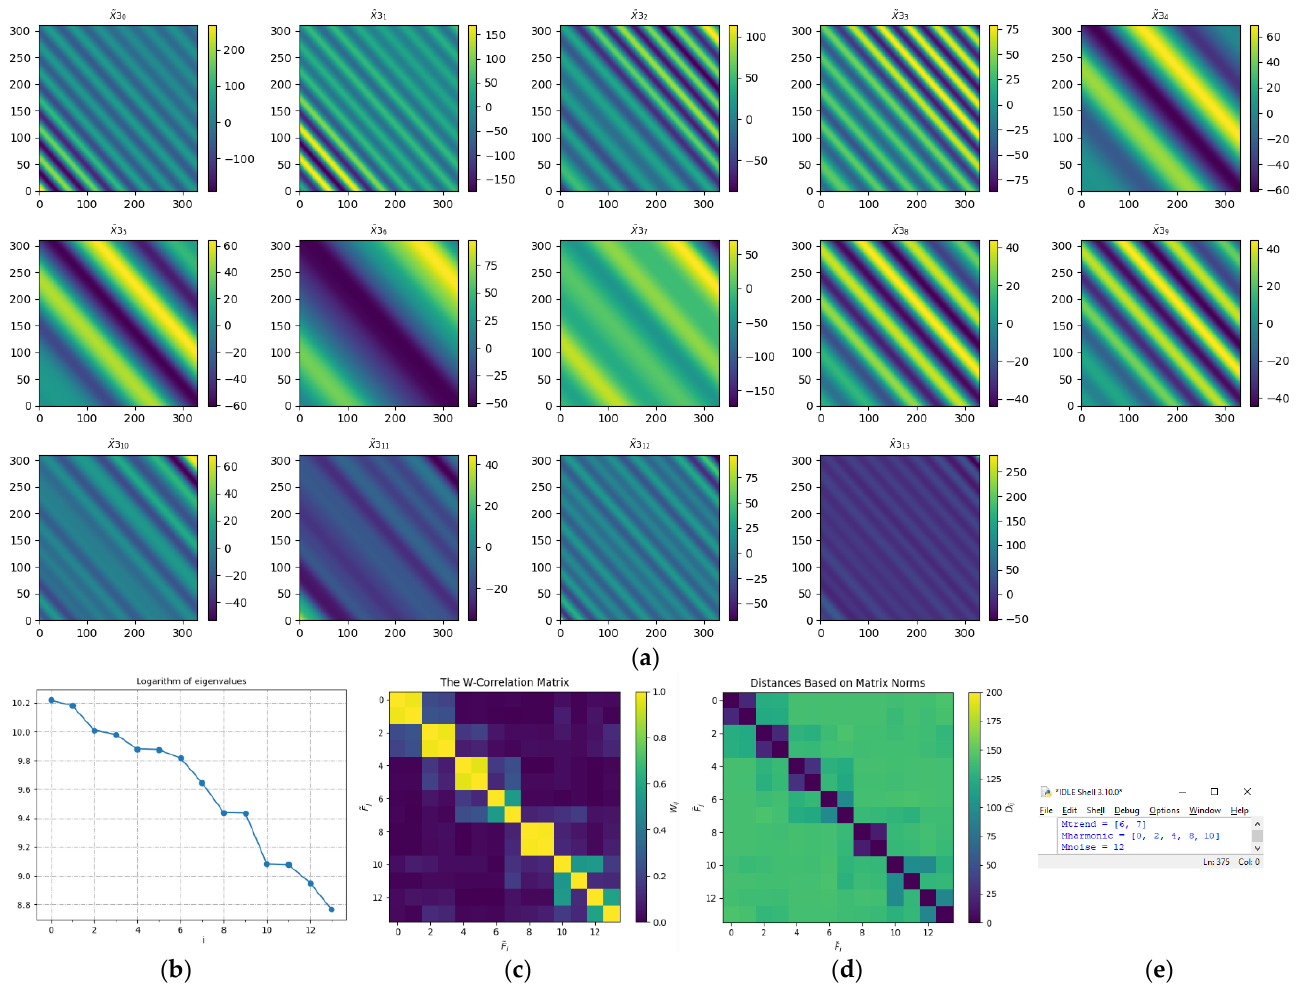
Figure A2. The result of matrix X3 decomposition and principal components analysis: ( a ) Hankelized principal components matrices; ( b ) the first 14 singular values of the trajectory matrix X3; ( c ) w-correlation matrix of distances between pairs of principal components; ( d ) matrix of distances between pairs of principal components based on the Frobenius norm; and ( e ) the result of the proposed algorithm, where Mtrend is the list of indexes of the singular numbers corresponding to the trend, Mharmonic is the set of indexes of the first elements from the pair, and Mnoise is the index of the singular number from which the noise components begin.